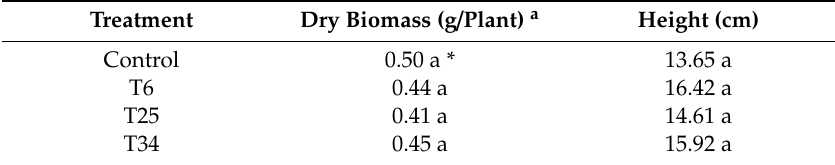
Table 2. Dry biomass and height in 4-week-old tomato plants at 72 hpi of Pseudomonas syringae pv. tomato under three Trichoderma